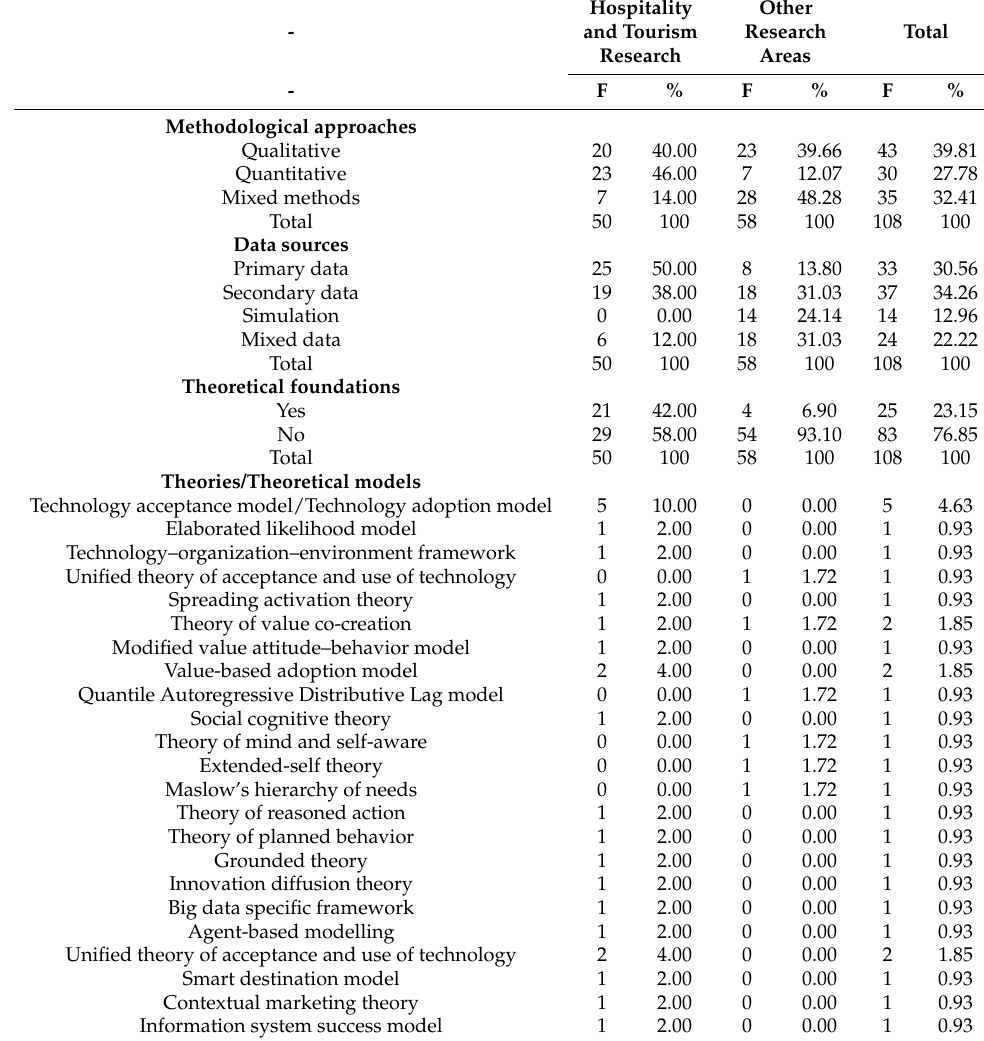
Table 2. Applied research methods and theories or theoretical models.